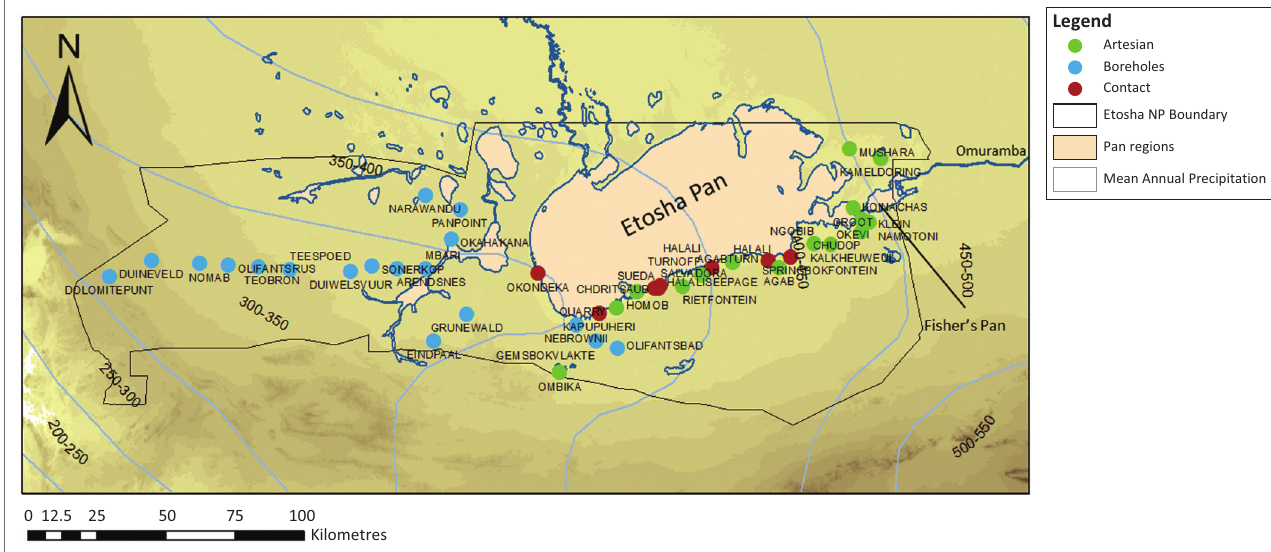
FIGURE 1: Location of groundwater sampling points following an approximate west-east (Dolomietpunt to Kameldoring) and south-north (Eindpal to Mbari) transect in the Etosha National Park, May